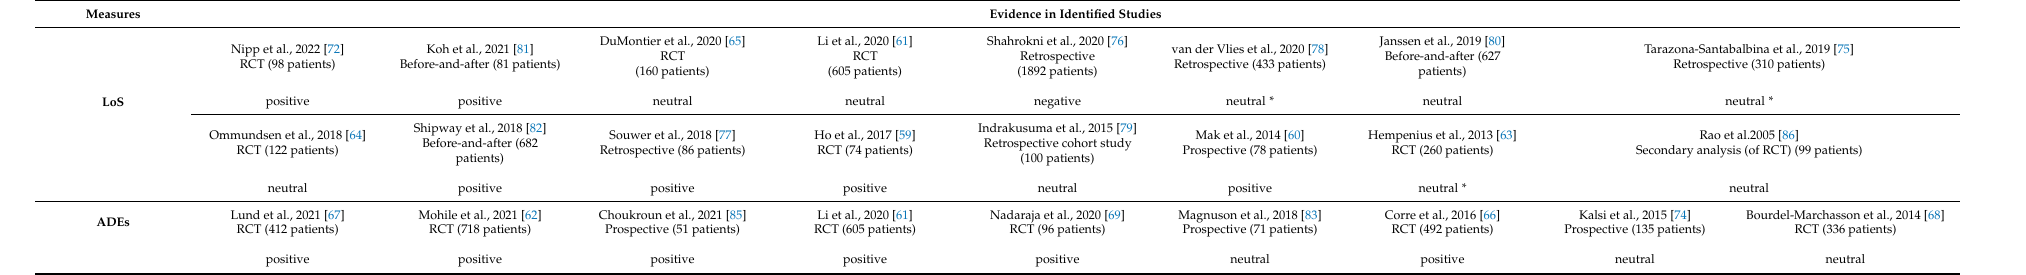
Table 4. Most recurrent reported measures for effectiveness of CGA